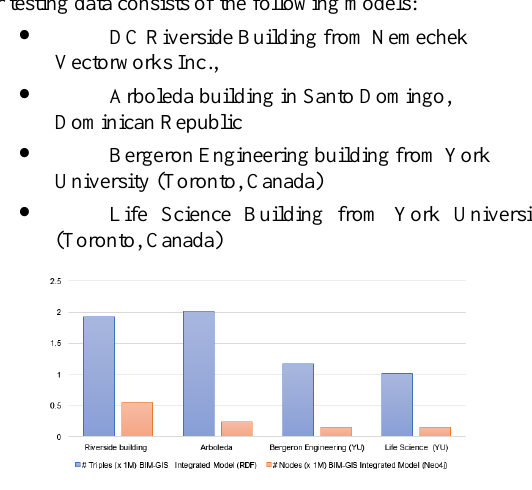
Figure 13: Testing datasets